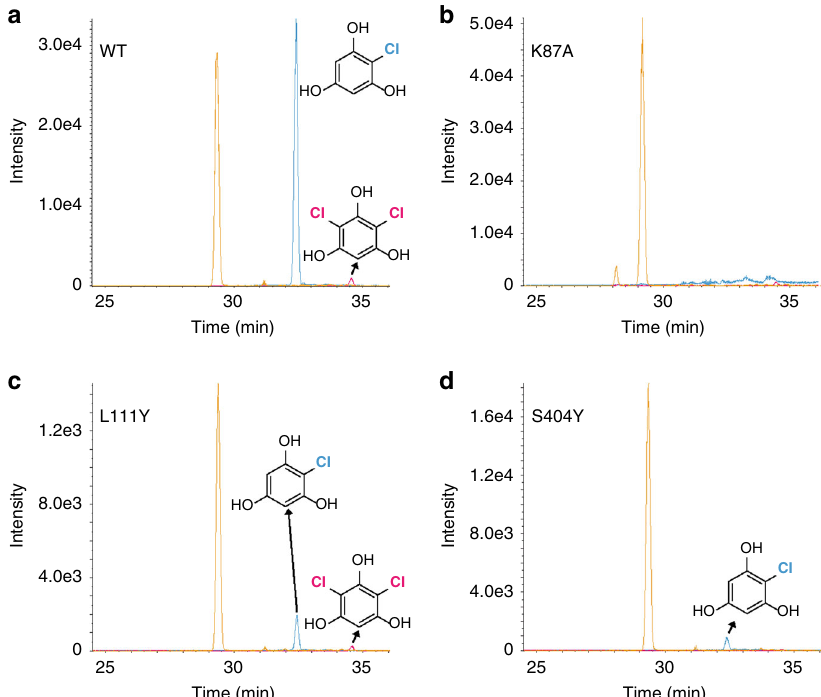
Fig. 5 Halogenation by PltM and its mutants in a cell-based assay. XIC traces of the cell-based halogenation assay using wild-type PltM ( a ), PltM K87A ( b ), PltM L111Y ( c ), and PltM S404Y ( d ). The blue trace refers to the mono-chlorinated 1 while the pink trace shows the dichlorinated 1 . The orange trace refers to unmodi fi ed starting compound